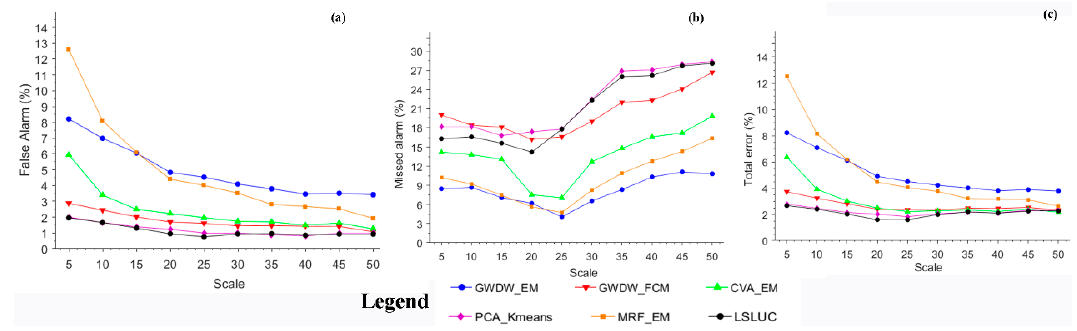
Figure 12. Analysis of the segmentation parameters’ sensitivity for the proposed OBEM post-processing LCCD method with the second data set: ( a – c ) present the relationship between FA, MA, and TE and the parameter scale of FNEA segmentation algorithm, respectively.